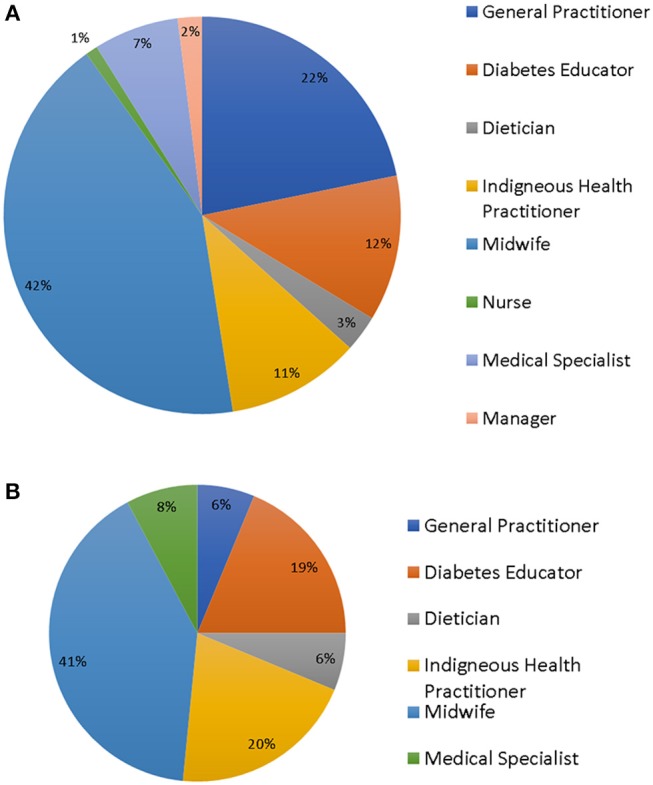
(A) Survey participants. (B) Focus group participants.